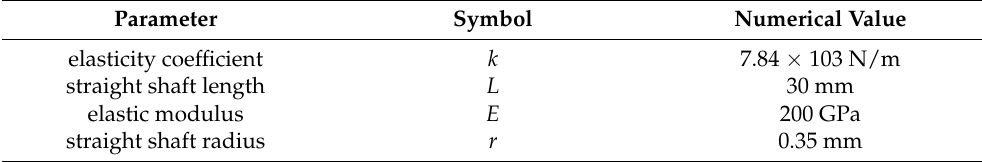
Table 1. Characteristics of spring-desensitized